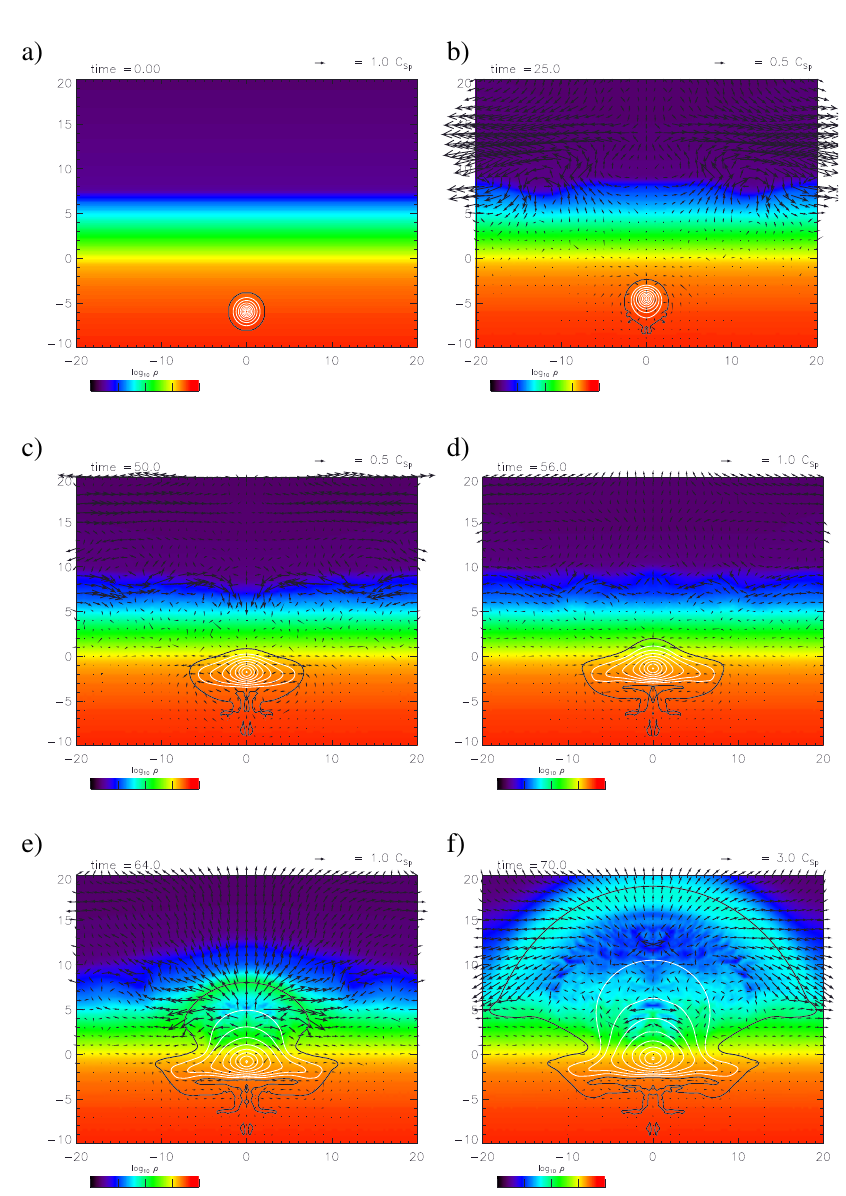
Figure 21: 2.5D simulation of the cross section of an emerging twisted flux tube by Magara (2001). In all panels the color coding indicates the density stratification and the arrows indicate the flow velocity in the plane of the simulation domain. The development of a magnetic buoyancy instability at the top of the tube (see panels d to f) leads to the dramatic expansion of the emerging flux into the coronal layers. Image reproduced with permission, copyright by